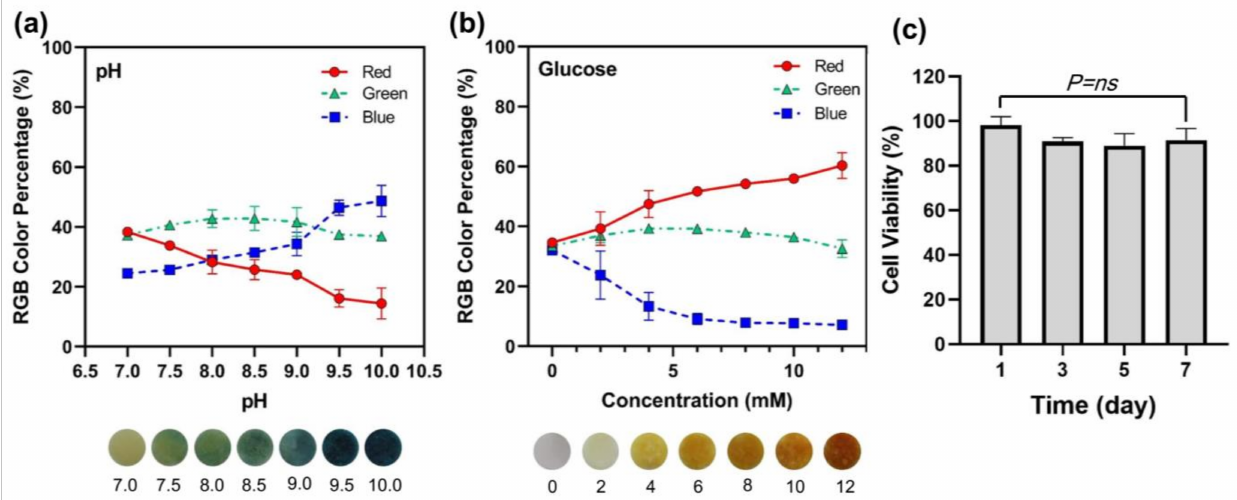
Figure 5. ( a ) RGB color percentage changes for the pH sensing; ( b ) RGB color percentage changes for the glucose sensing; ( c ) Cell viability test results for 50% PEGDA